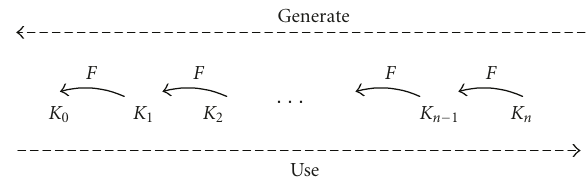
Figure 8: Generation of keys at the gateway, using a one-way hash function.